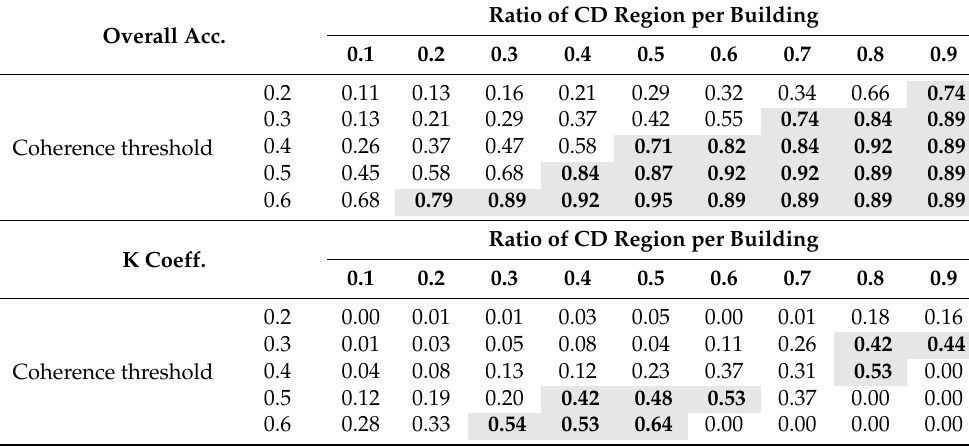
Table 4. Overall accuracy and Cohen’s Kappa coefficient for coherence analysis with buildings over 200 m 2 and with DL 5 or greater. Bold numbers with gray background represent the cells which accuracy and K-coefficient are over 0.7 and 0.4